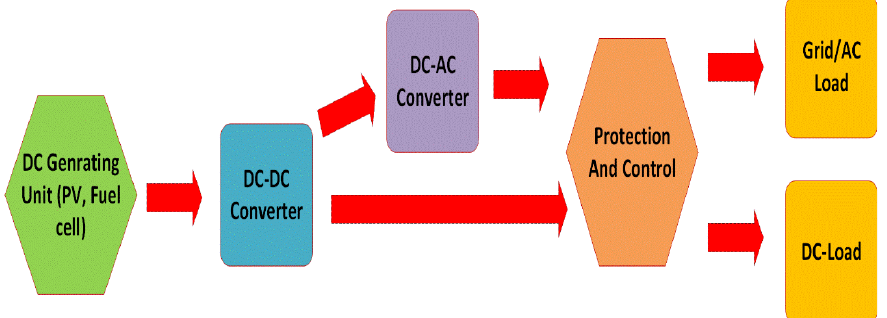
Figure 2. Multiport converters for DC grid integration.